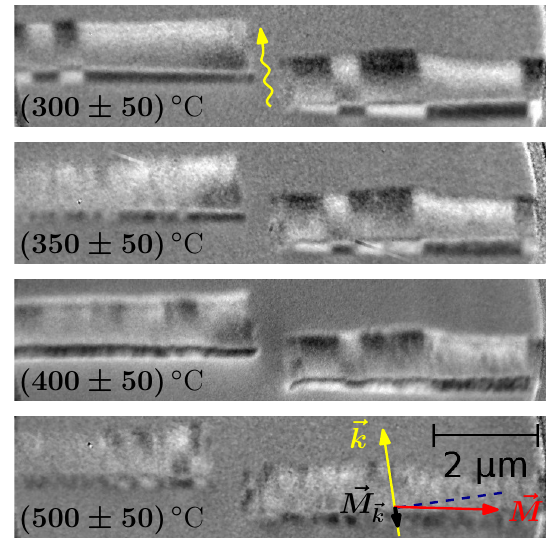
Fig. 4: Changing the magnetic anisotropy upon annealing of the tubes . XMCD- PEEM images (same contrast range [ -13%..13% ] ) of the same tubes after annealing at increasing temperature. All images are taken after cooling down to room temper- ature. The X-ray beam arrives close to perpendicular to the tube axis as indicated by the arrow. With the increasing annealing temperature, the azimuthal magnetization pattern becomes weaker and gradually disappears, persisting only close to the tube extremity (end curling). The degree of the transformation is not the same for both tubes, probably due to a different tube wall thickness. After remagnetization along the tube axis (bottom image), both tubes display close to uniform contrast in the shadow, a sign of magnetization pointing along the tube axis. The contrast (bottom image) is weak due to a very small component of the magnetization along the